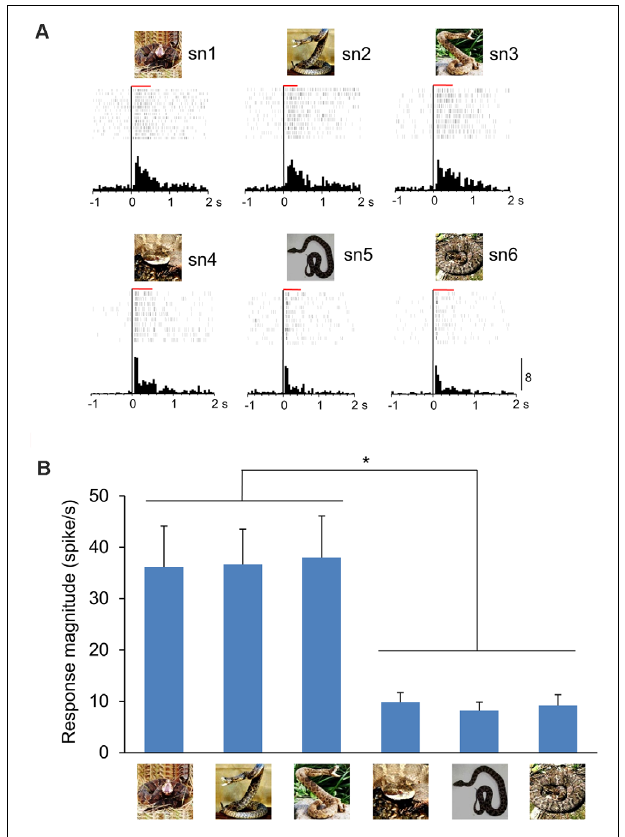
FIGURE 2 | A representative mPFC neuron sensitive to snake postures. (A) Peri-event histograms of the mPFC neuronal activity in response to each snake photo. Each raster display above each histogram indicates neuronal activity. The red horizontal bars above the raster display indicate the stimulus presentation period (500 ms). Zero in the abscissas indicates the stimulus onset. Calibration at the right bottom of the figure indicates the number of spikes per trial in each bin. Bin width = 50 ms. (B) Response magnitudes of this neuron to the six snake images. Histograms indicate mean ± SEM. * p < 0.05.